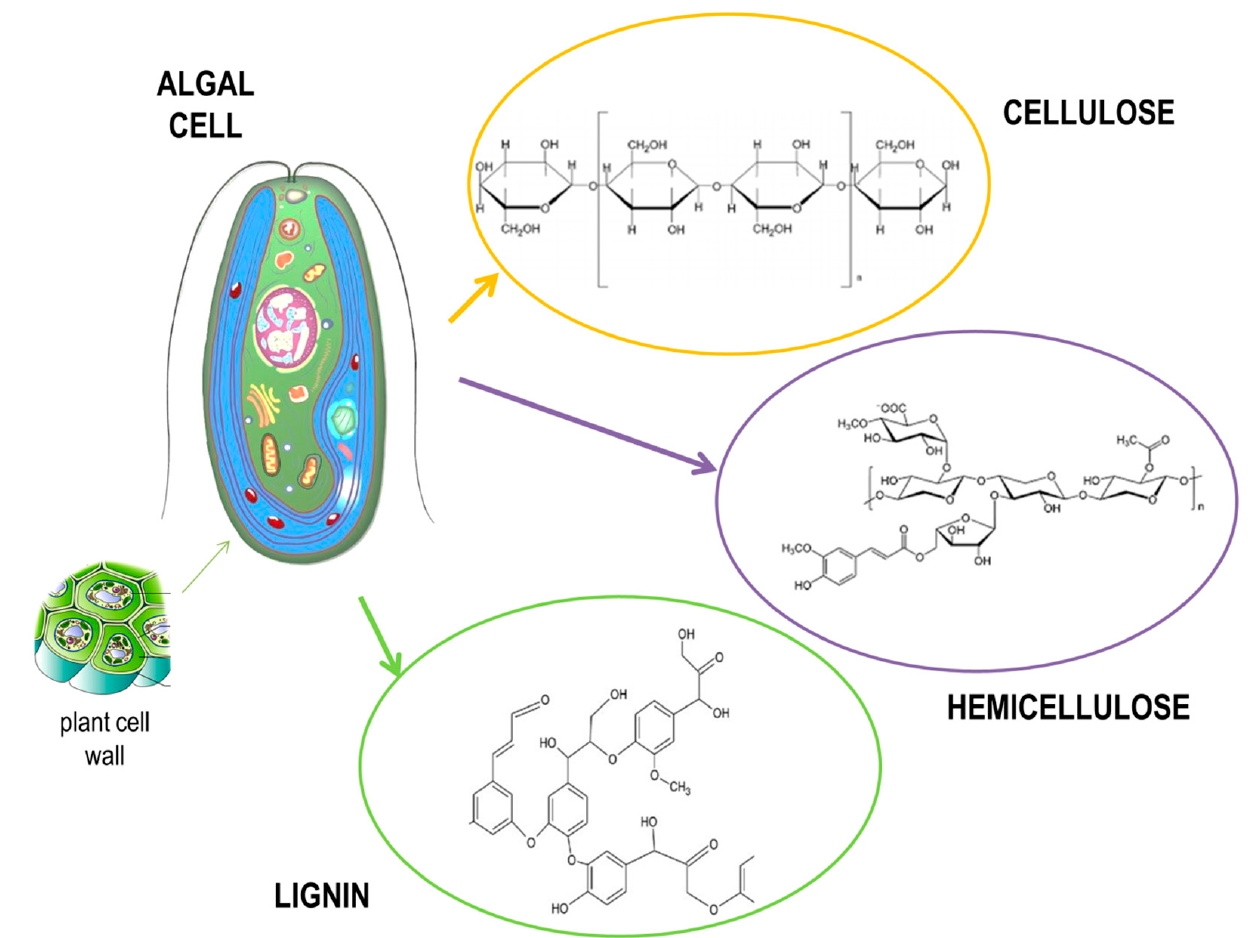
Figure 3. Structure of an algal cell.